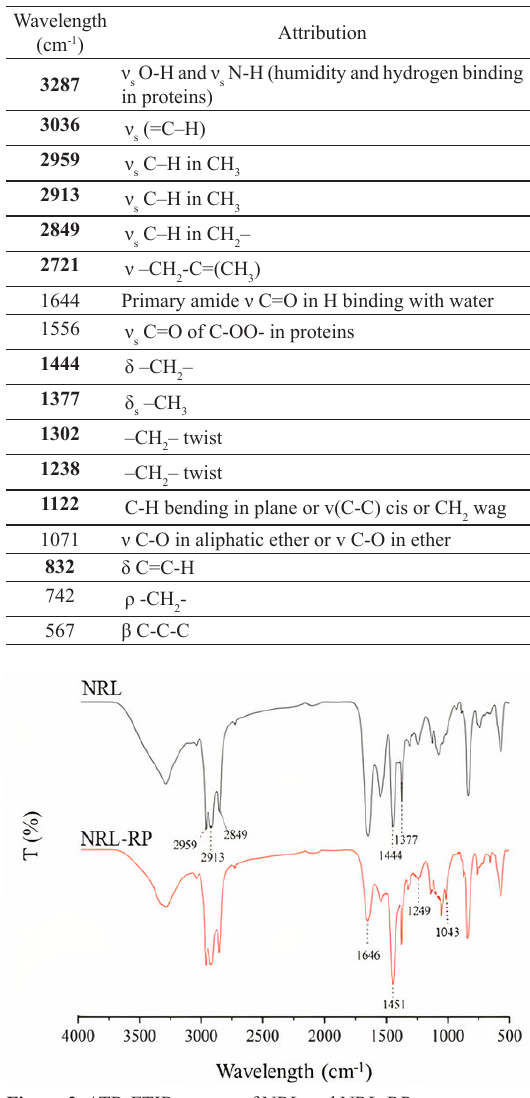
Table 3. Absorption bands attribution for each found wavelength 38,48,49 in NRL ATR-FTIR spectrum.